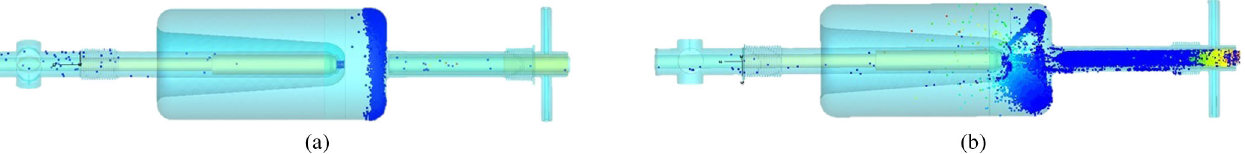
FIG. 6. Stable trajectories in the gun based on the CST simulation results: (a) trajectories at the front rounding of the cavity at 28 kVof accelerating voltage, (b) stable trajectories between the nose and the front rounding of the cavity at 40 kV of accelerating voltage.